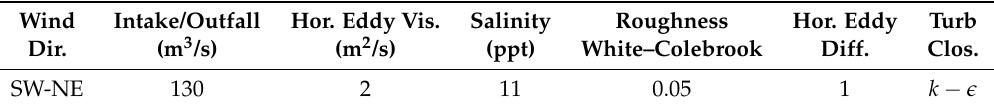
Table 3. General settings of model